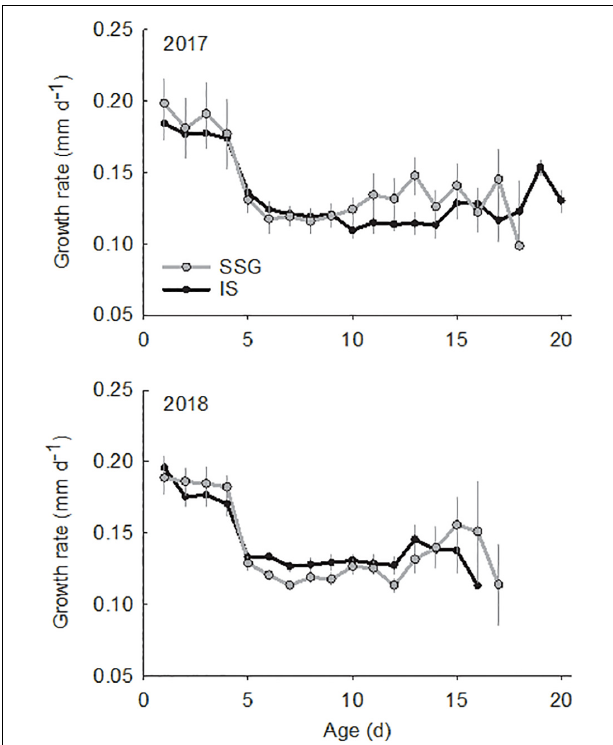
FIGURE 8 | Comparison of mean daily growth rates (mm d − 1 ) for King George whiting larvae from Southern Spencer Gulf (SSG; light) and Investigator Strait (IS; dark) in 2017 and 2018. Error bars are ± 1 SE.